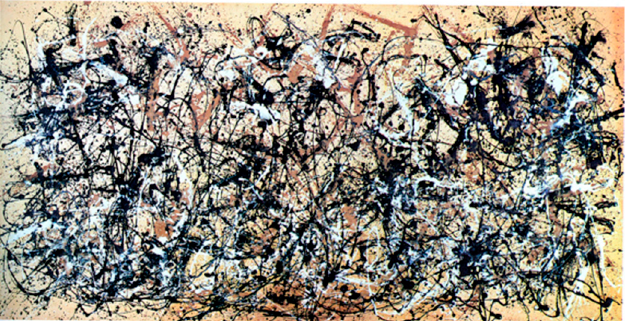
Figure 5. Jackson Pollock, Autumn Rhythm: Number 32 , 1950 , 1950, enamel on canvas, 105 × 207 in. (266.7 × 525.8 cm). The Metropolitan Museum of Art, New York. George A. Hearn Fund, 1957. © 2022 The Pollock-Krasner Foundation/Artists Rights Society (ARS), New York.